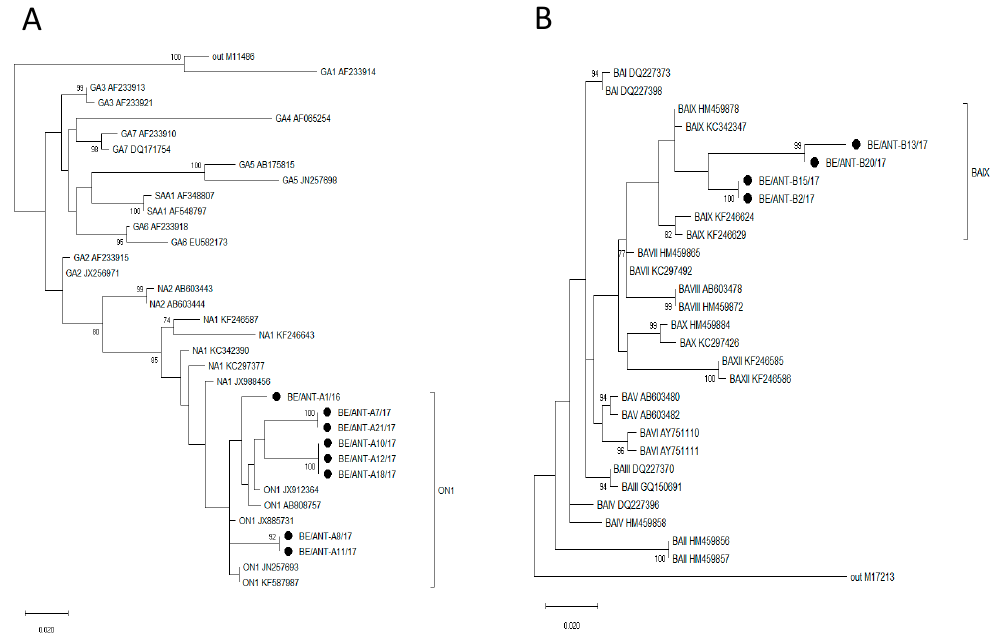
Figure 1. Phylogenetic trees for RSV-A and RSV-B clinical isolates. The phylogenetic trees were constructed with maximum-likelihood with 1000 bootstrap replicates using MEGA X software. The trees are based on a 342nt and 330nt fragment of the G protein of RSV-A ( A ) and RSV-B ( B ) strains respectively, consisting of the second hypervariable region. Nucleotide sequences of the clinical isolates (indicated with • ) were compared to reference strains found on GenBank (indicated with genotype and accession number). The outgroups are represented by prototype strains M11486 for RSV-A and M17213 for RSV-B. Bootstrap values greater than 70% are indicated at the branch nodes and the scale bar represents the number of substitutions per site.